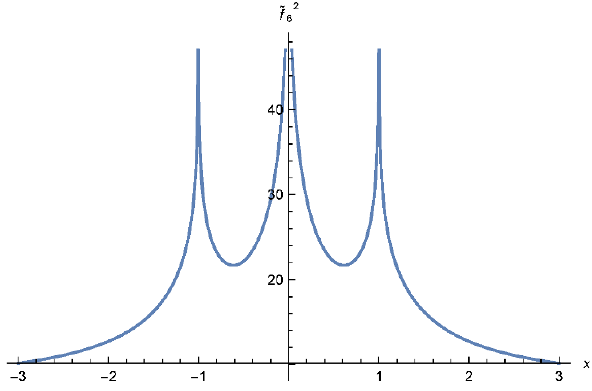
Figure 4 . The function ~ f 2 , evaluated on the boundary of (cid:6) for the three external brane background 6 with ( p 1 ; p 2 ; q 1 ; q 2 ) = (1 ; 1 ; (cid:0) 1 ; 1). Note that the global minimum is at in(cid:12)nity. This is an example of what will be referred to as a Sector 1 probe string in section